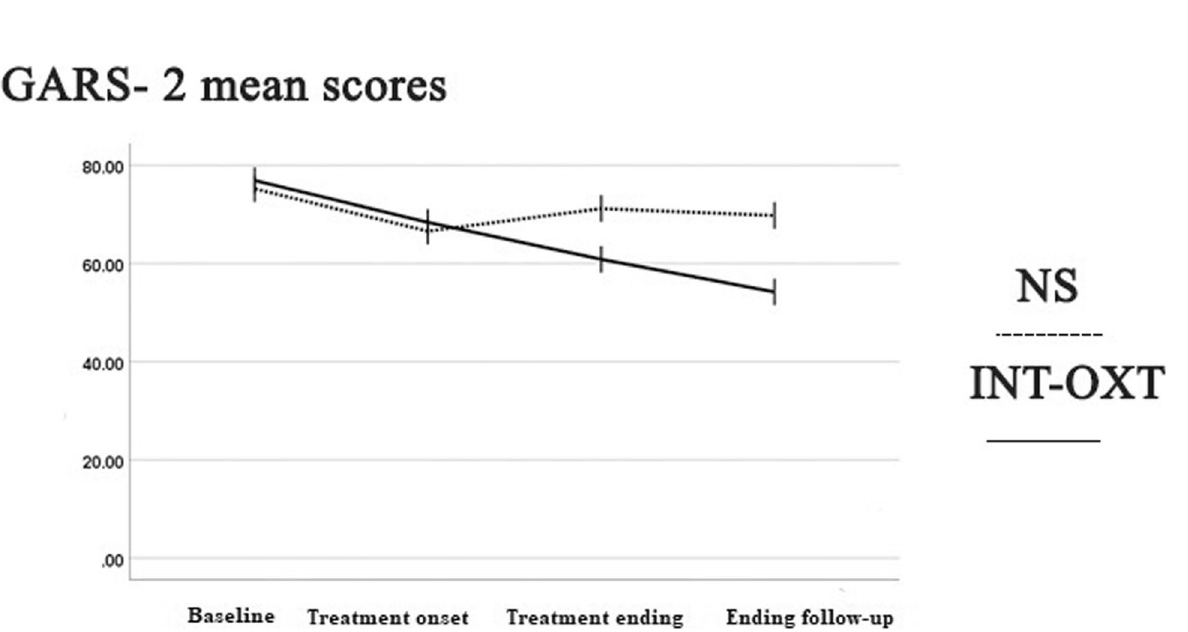
INT-OXT intranasal oxytocin, NS normal saline. Categorical data were compared using chi-square, and the repeated-measure ANOVA model was used for continuous parameters